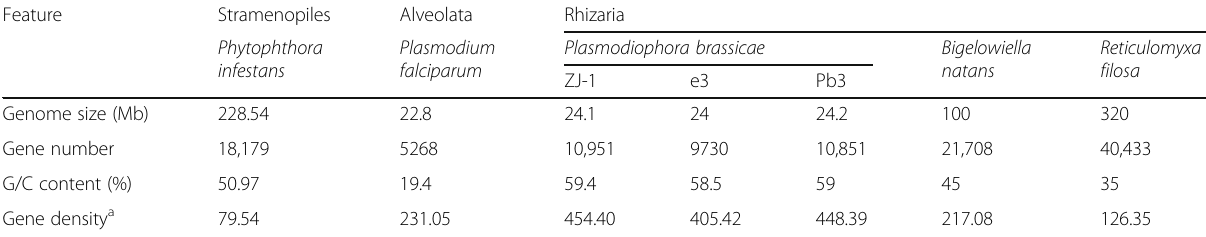
Table 2 Genome comparison of Plasmodiophora brassicae and the other representative SAR supergroup